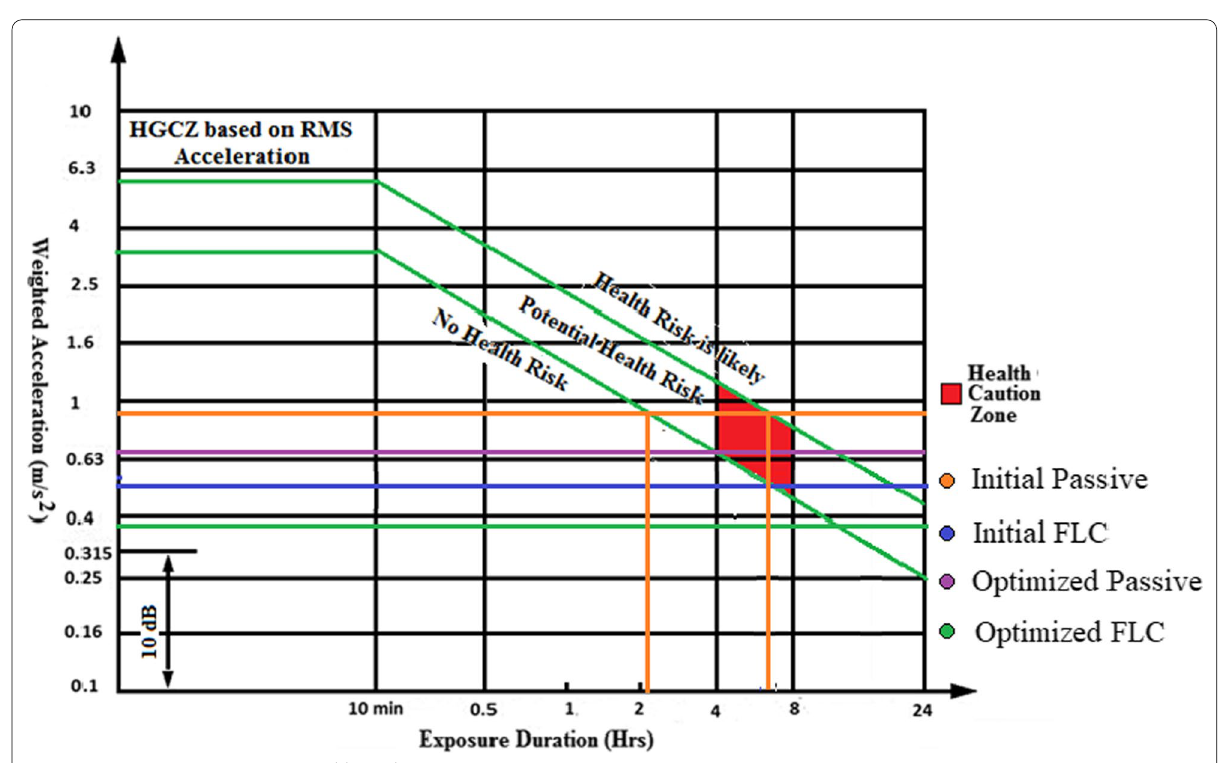
Fig. 12 Annexure B—ISO 2631-1 (Health Guidance Caution Zone, HGCZ) [25]